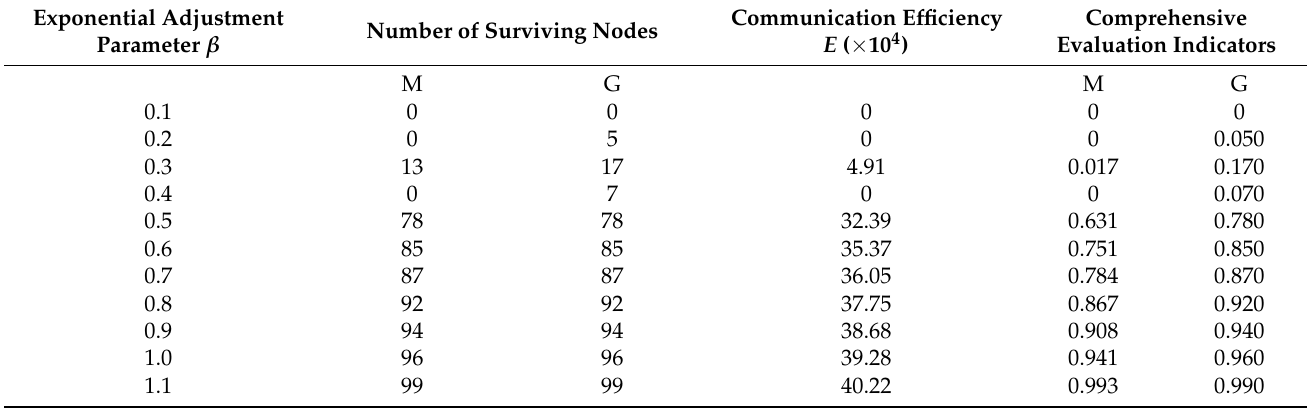
Table 2. The experimental